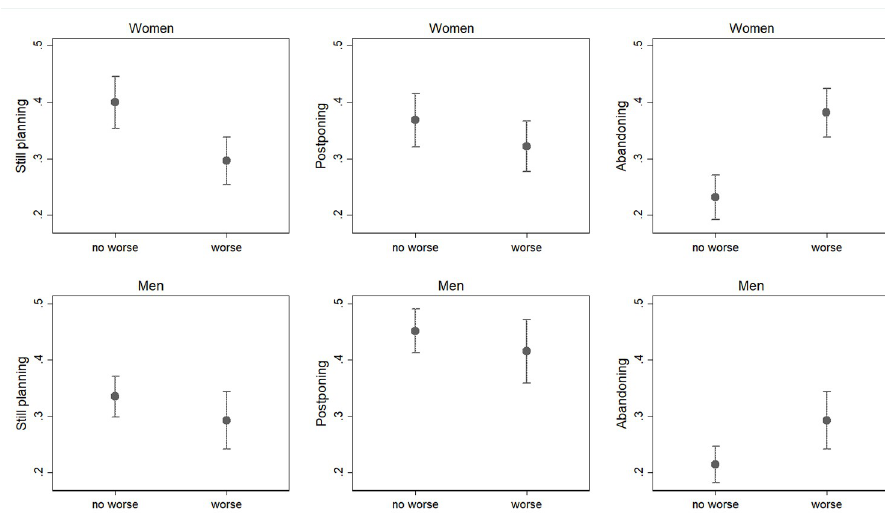
Fig 3. Predicted probabilities of changes or confirmations of pre-COVID fertility plans in March and October 2020 for those who experienced and those who did not experience a worsening in their financial situation (confidence intervals for pair-wise comparisons at the 5% significance level; March and October 2020 waves pooled). Note: Predicted probabilities bases on a multinomial logit model, controlling for age class, education, marital status, presence of children. Full results are available in S1_2 and S1_3 Tables in S1 Appendix. Confidence intervals are calculated to allow for multiple comparisons of predicted probabilities, i.e. to allow testing their statistical equality at an approximate 5% significance level. Overlap between a pair of intervals indicate that the corresponding predicted probabilities are not statistically different at the 10% level, while non-overlap indicate a significant difference. No differences in terms of significancy has been found with confidence intervals at